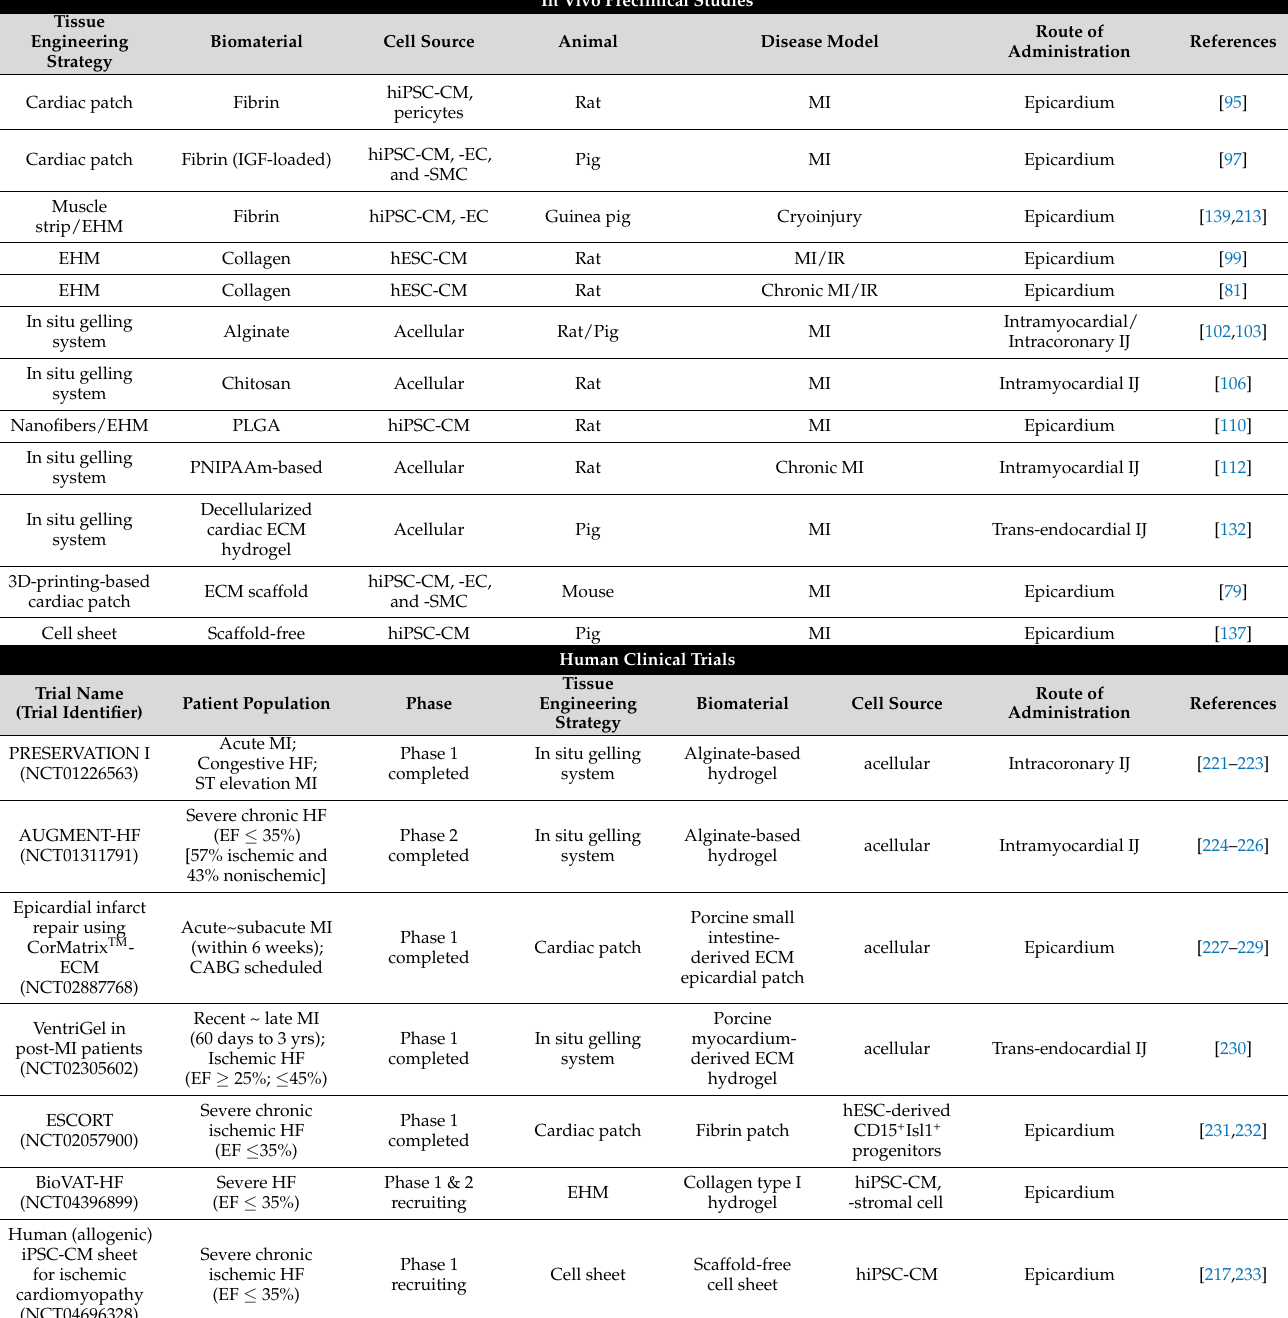
Table 2. The selected in vivo preclinical studies and human clinical trials of cardiac tissue engineering-based therapies for heart regeneration and repair. CABG, coronary artery bypass grafting; CM, cardiomyocyte; EC, endothelial cell; ECM, extracellular matrix; EF, ejection frac- tion; EHM, engineered heart muscle; hESC, human embryonic stem cell; hiPSC, human inducible pluripotent stem cell; HF, heart failure; IGF, insulin-like growth factor; IJ, injection; IR, ischemia reperfusion injury; MI, myocardial infarction; PLGA, poly(lactic- co -glycolic acid); PNIPAAm, poly(N- isopropylacrylamide); SMC, smooth muscle cell. In Vivo Preclinical Studies Tissue Disease Model Route of